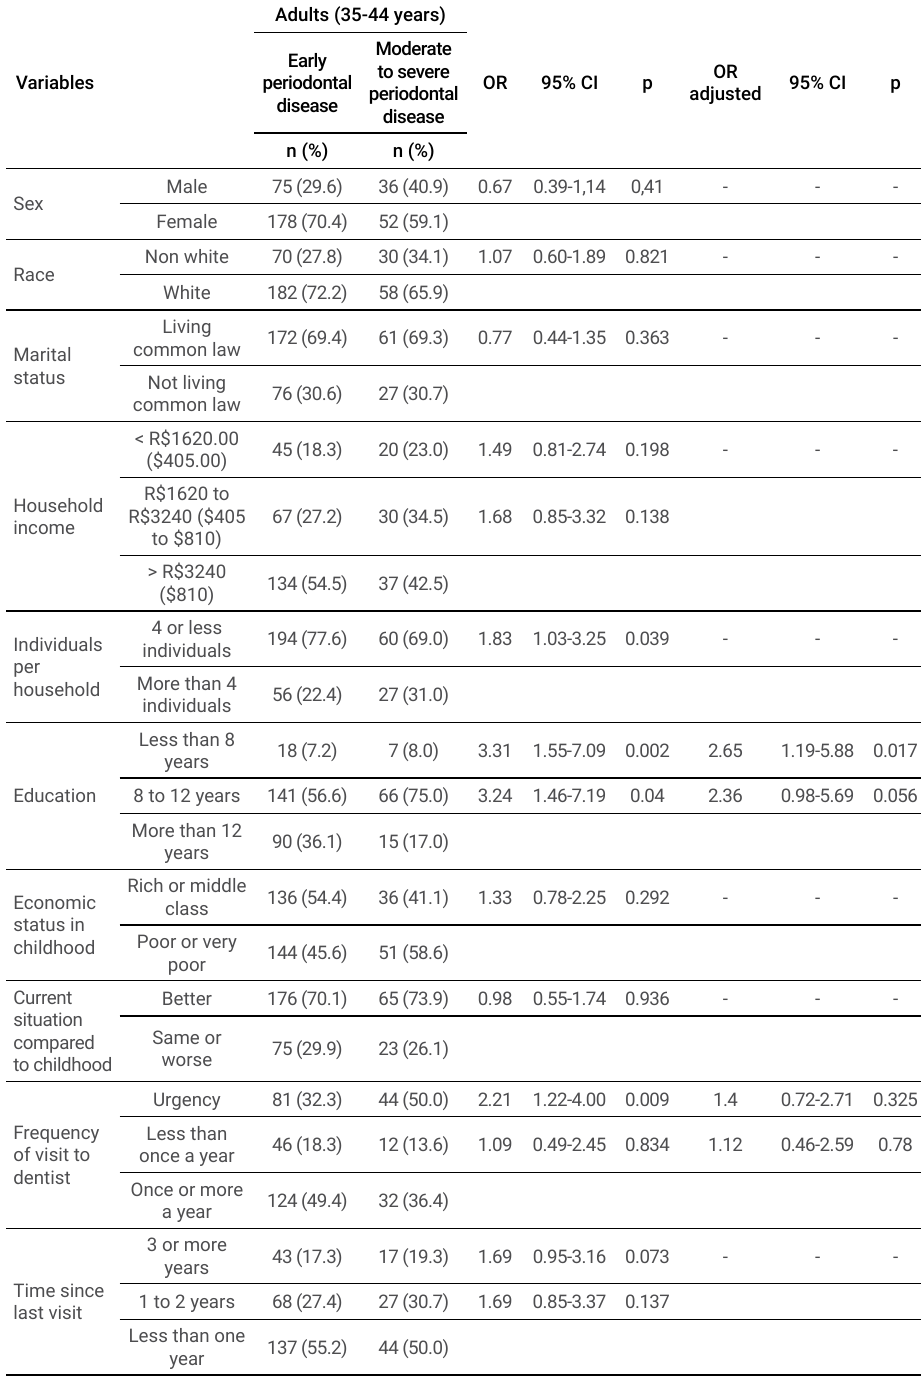
Table 3. Multivariate analyses of factors associated with moderate to severe periodontal disease in adults from Jundiaí City .